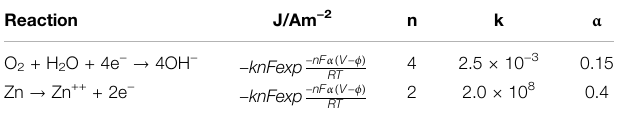
TABLE 3 | Parameters considered during